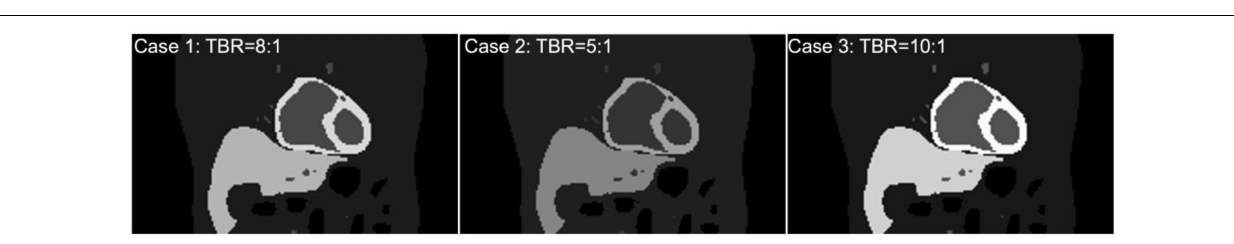
FIGURE 5 | (Top) Coronal view of the activity maps for different TBRs at time t = 360 s after the tracer injection (Case 1, 2, 3). All images were normalized by the maximum pixel value of the image with TBR = 10 (Bottom).